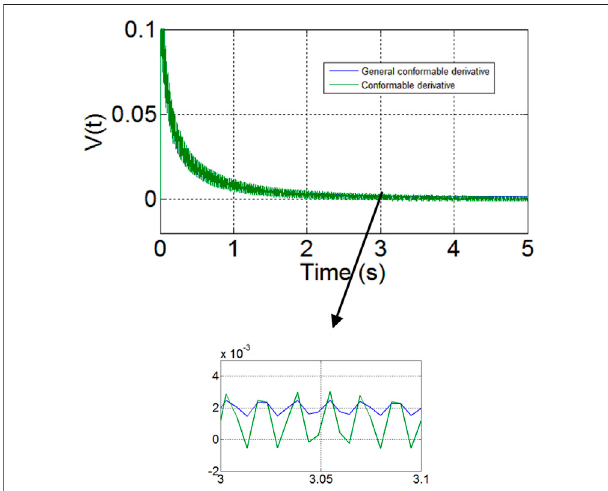
FIGURE 7 | Evolution of V ( t ) with α (cid:2) 0 . 4.